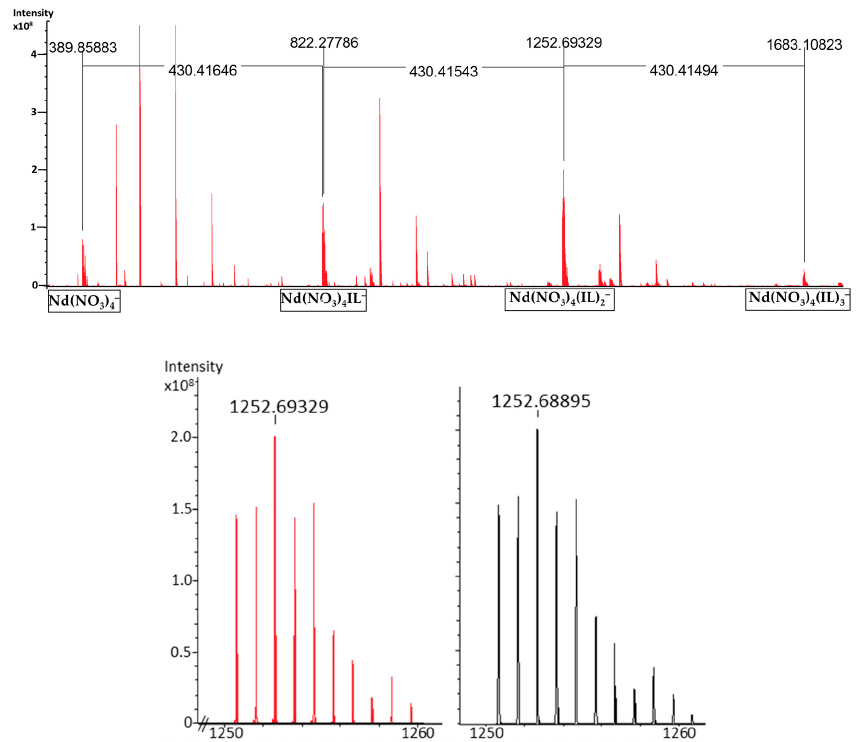
Figure 6. ( Top ): Negative-ion mode ESI-MS of the IL organic phase (0.1 M IL ) post-contact with an Nd aqueous phase diluted with methanol showing ions of Nd(NO ₃ ) ₄ (IL) n − with m / z 391.8611 ( n = 0, calc. 391.8596), 822.2779 ( n = 1, calc. 822.2755), 1252.6933 ( n = 2, calc. 1252.6890), and 1683.10823 ( n = 3, calc. 1683.1024). ( Bottom ): Experimental negative-ion ESI-MS for n = 2 (red) compared with that calculated (black).